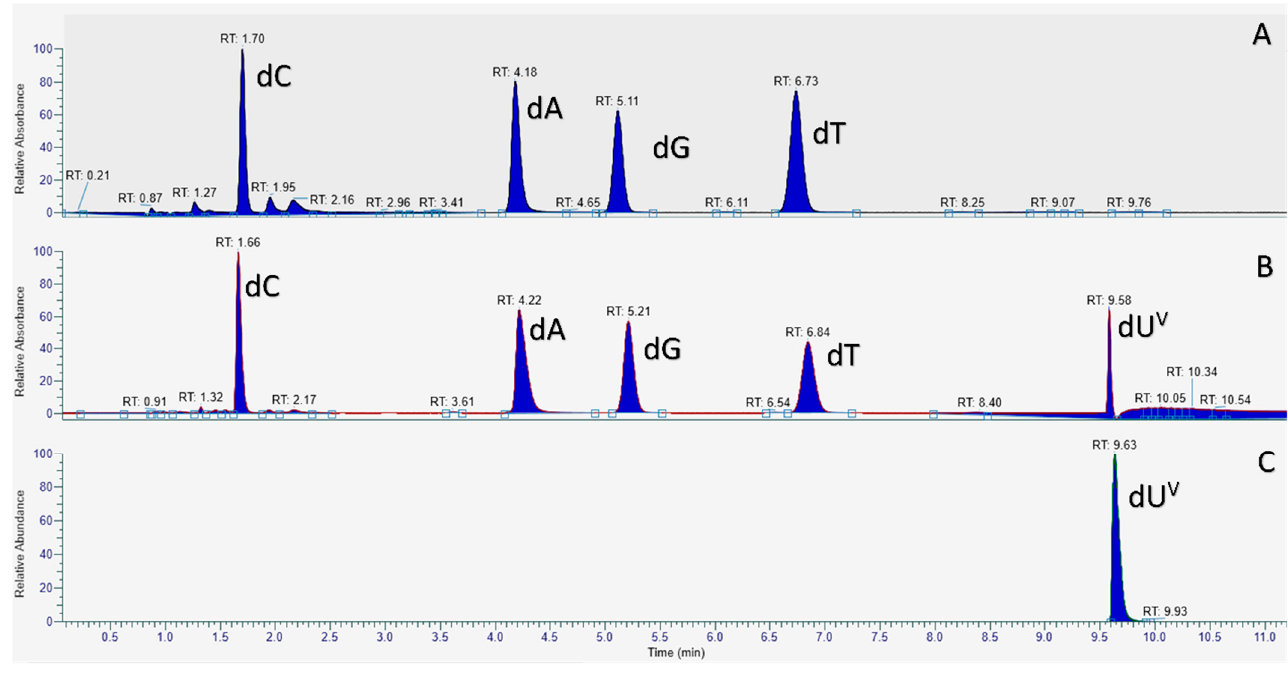
Figure 3. LC-MS chromatograms of deoxynucleosides from digested PEX reaction products obtained with dU Van TP and dTTP. ( A ) LC-MS chromatogram of the digested product obtained with dTTP; ( B ) LC-MS chromatogram of the digested product obtained with dU Van ; ( C ) LC-MS chromatogram of the synthesized dU Van standard.